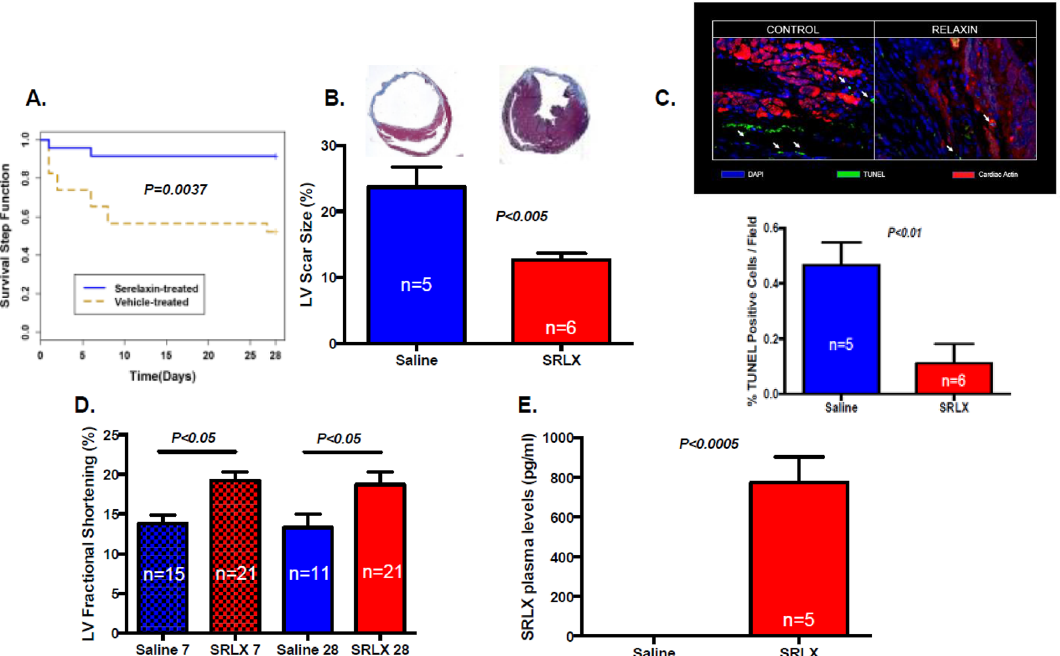
Figure 2. Preserved cardiac health upon chronic treatment with serelaxin. ( A ) Chronic treatment with Serelaxin (10 µg/kg/day) improves the survival in mice, as demonstrated in the Kaplan–Meier curve for survival analysis in vehicle-treated or serelaxin-treated (via osmotic mini-pumps) mice for 28 days; ( B ) The percentage of LV scar size is significantly lower in the serelaxin treated group, as assessed via trichrome staining; ( C ) The percentage of TUNEL positive cells is significantly lower in cardiac sections from serelaxin-treated mice; ( D ) Fractional shortening is significantly preserved in serelaxin-treated mice at 7 days and 28 days post induction of permanent ligation surgery; ( E ) Plasma serelaxin levels reach ~ 800 pg/ml in mice implanted with drug eluting osmotic pumps, while animals receiving saline eluting pumps have no plasma relaxin levels, as detected via ELISA.